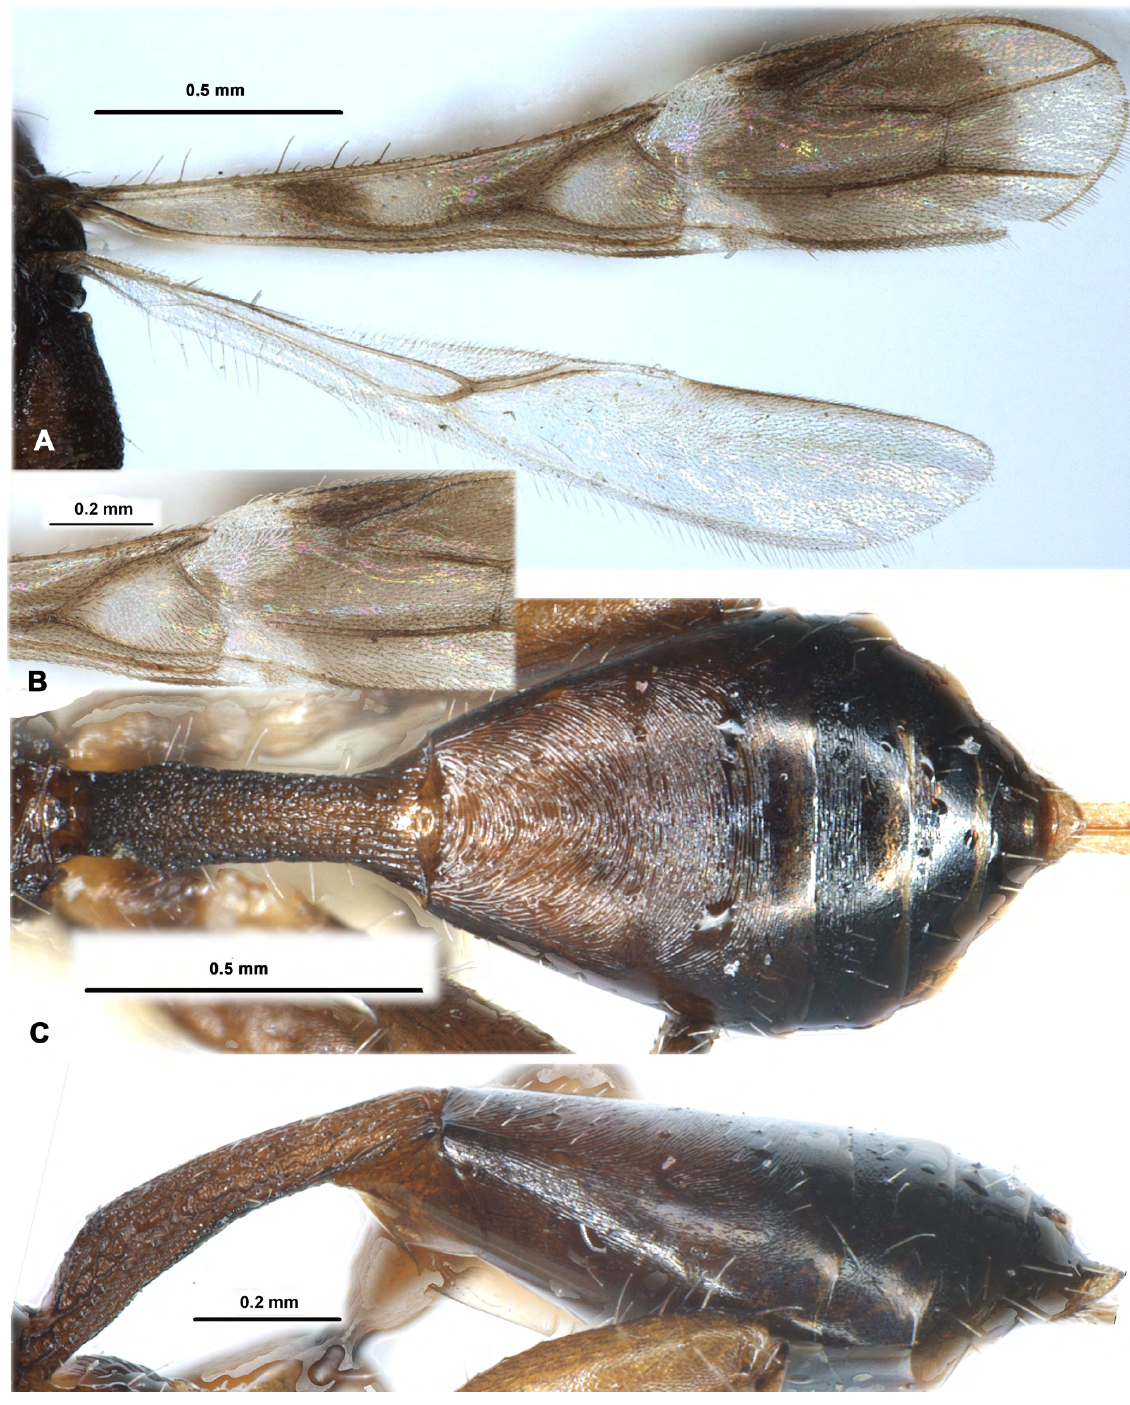
Fig. 2. Antespathius buonluoicus (Belokobylskij, 1995), ♀, holotype, ZISP. A . Wings. B . Fore wing, median part. C . Metasoma, dorsal view. D . Metasoma, lateral